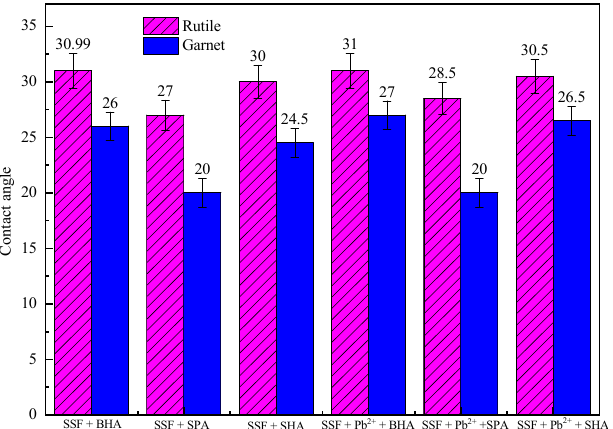
9 of 13 Figure 10. Effects of reagents on the hydrophobicity of rutile and garnet. The effects of different chemical combinations on the surface hydrophobicity of rutile and garnet are shown in Figure 11. In the absence of the activator Pb 2+ , the chemical